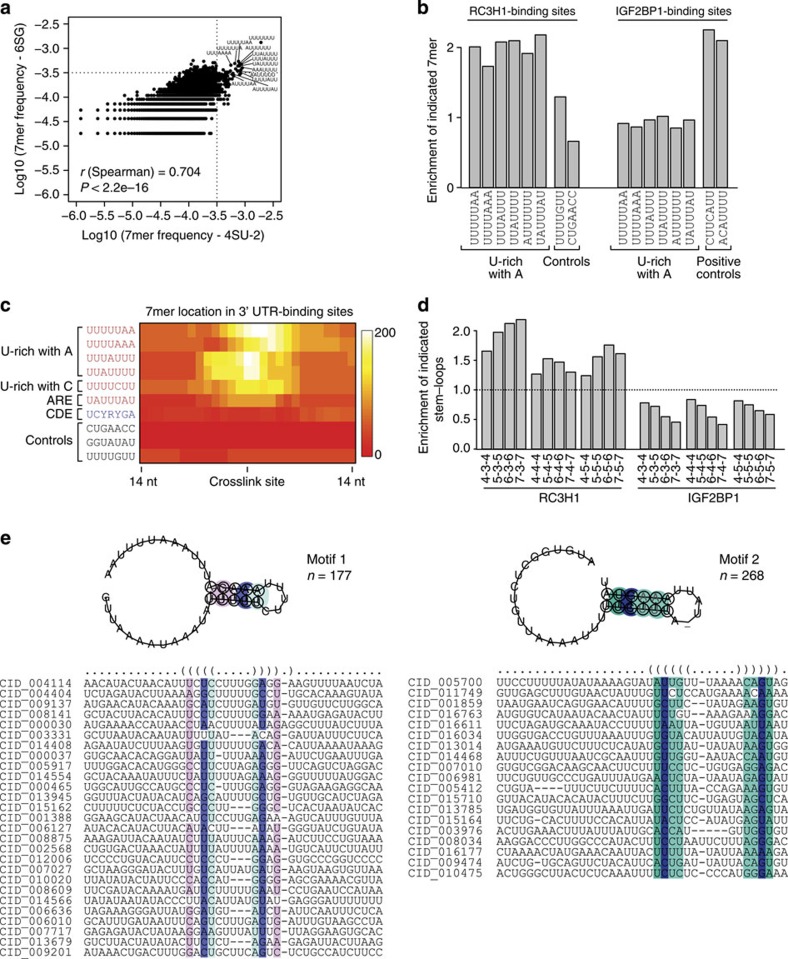
Identification of U-rich sequences and stem–loop secondary structure as recognition elements of RC3H1.(a) Log10 frequencies of 7mers occurring in the 41-nucleotide (nt) window around the RC3H1 preferred crosslink sites are shown for 4SU-2 PAR-CLIP and 6SG PAR-CLIP libraries. U-rich sequences are frequently occurring in both 4SU and 6SG libraries. (b) Enrichment of indicated 7mers in the 41-nt window around the RC3H1 (left) or IGF2BP1 (right) preferred crosslink sites compared with all 3′UTR sequences. U-rich sequences with A contents are specifically enriched in RC3H1 3′UTR-binding sites, whereas 7mers containing known IGF2BP1 motif (CAU) are enriched in IGF2BP1 3′UTR-binding sites to the similar degree. (c) A heat map showing the coverage of 7mers, indicated on the left, around the preferred crosslinks in 3′UTR RC3H1 consensus binding sites. U-rich elements with A contents and CDE are indicated. U-rich sequences are found in the close vicinity of crosslink sites, which is indicative of direct association of RC3H1 with U-rich sequences. (d) Enrichment of indicated stem–loop structures in the 41-nt window around the RC3H1 (left) or IGF2BP1 (right) preferred crosslink sites compared with 41 nt sequences randomly selected from the 3′UTRs of target transcripts as a background model. Various stem–loop structures (n-m-n indicates a hairpin structure of n-mer stem and m-mer loop) are enriched in RC3H1 3′UTR-binding sites but not in 3′UTR IGF2BP1-binding sites. (e) The seed alignment and consensus structure of motifs 1 and 2 are shown. ARE, AU-rich elements.